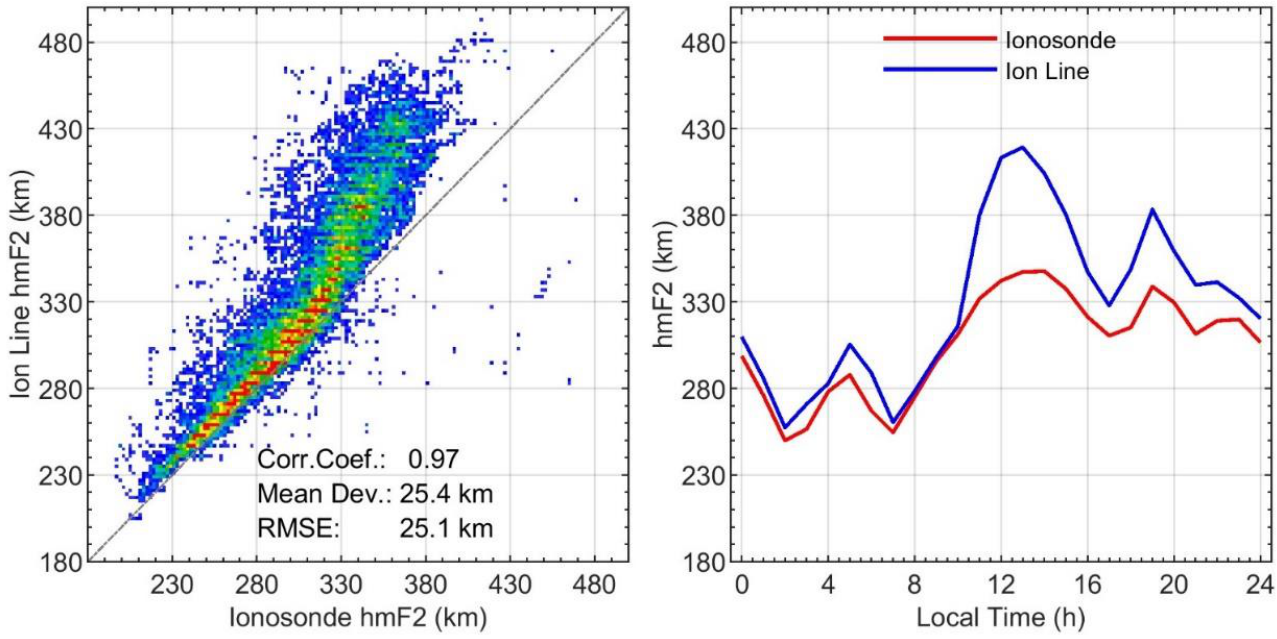
Figure 7. Comparison of ionospheric peak height ( h m F 2 ) between ionosonde measurements and SYISR ion line results during 12 March 2022 to 10 April 2022 in terms of versus plot ( left panel) and mean local time variation ( right panel).